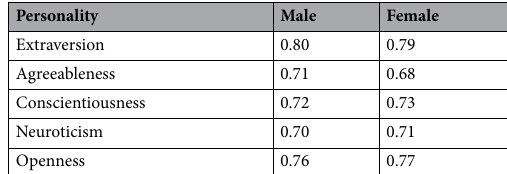
Table 1. Cronbach’s α in each of BF factor in two